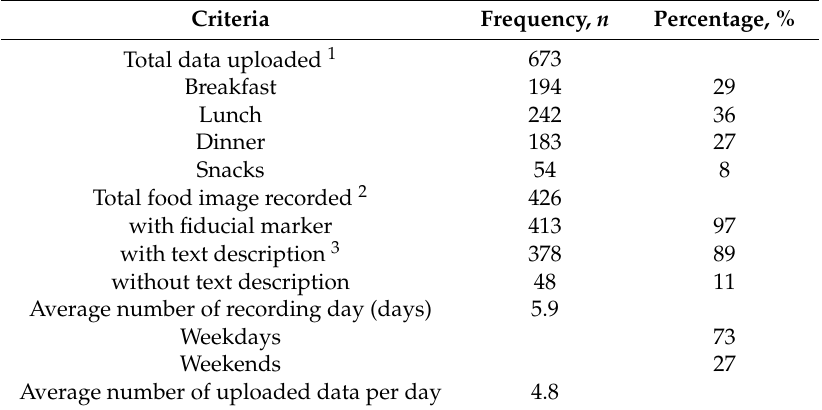
Table 1. Compliance in dietary reporting.